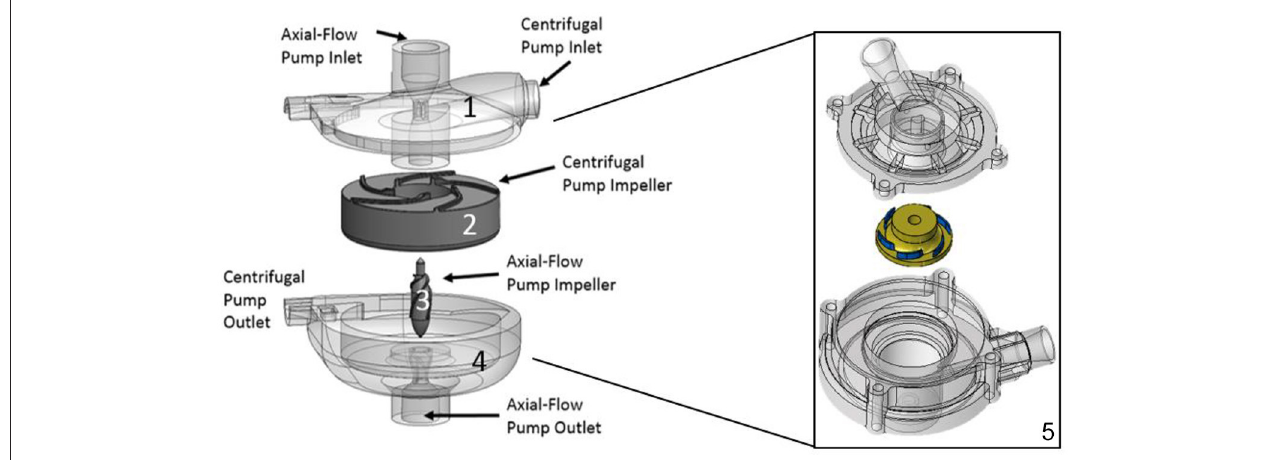
FIGURE 2 | Hybrid continuous-flow TAH. (1) Upper housing, (2) Centrifugal pump impeller, (3) Axial pump impeller, (4) Lower housing. This configuration consists of two separate pump domains combined into one pump housing, (5) Concentrated design focus on the centrifugal pump design only: Reduced overall size with an improved and compact centrifugal impeller and pump design, overall 60mm in diameter by 50mm in height, having a radial inlet volute and 37mm impeller diameter (6 bladed